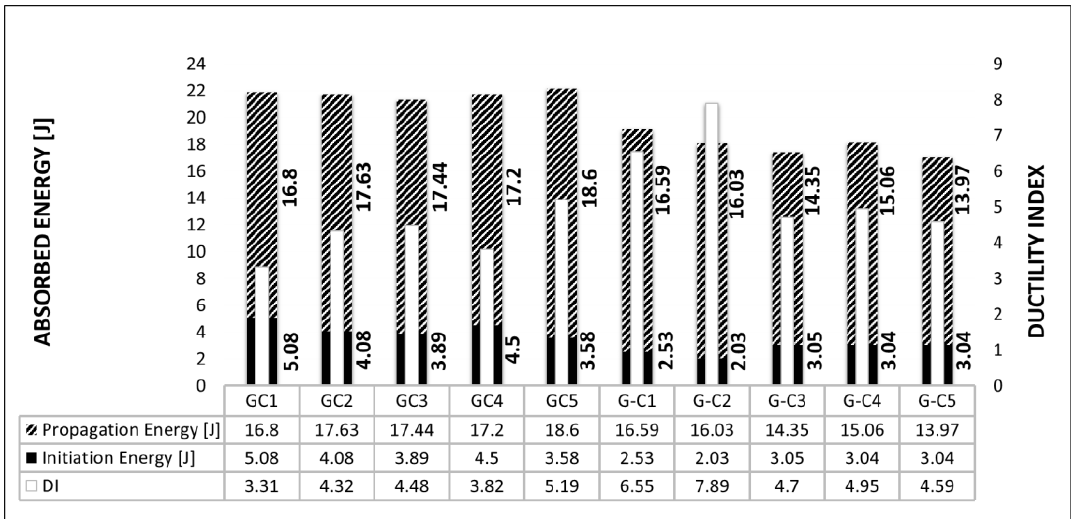
Figure 5. Absorbed energy divided into Ei and Ep and ductility index DI for each hybrid composite tested specimen.